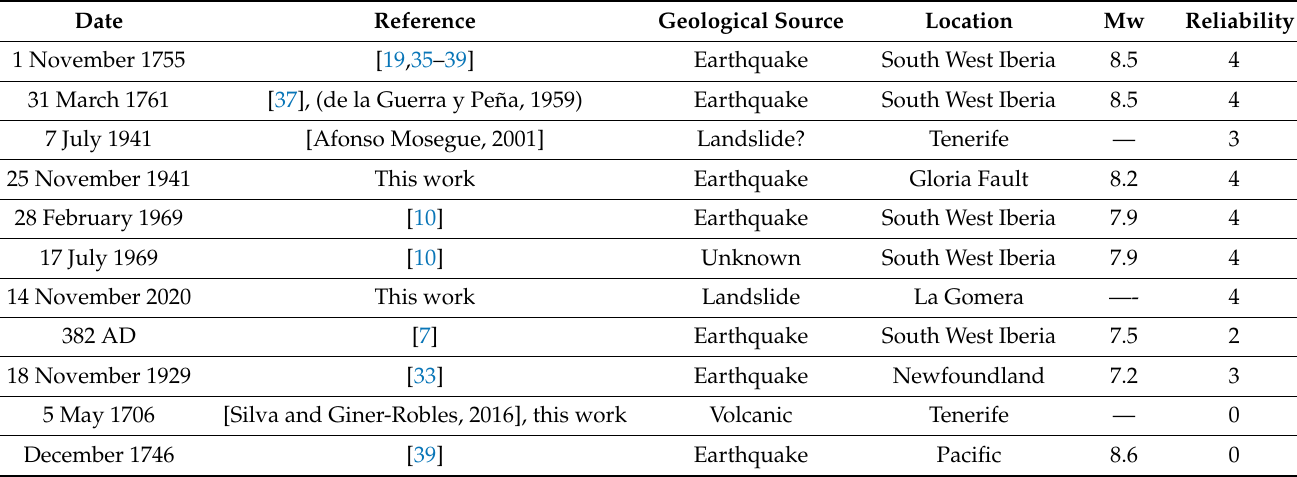
Table 1. Synthesis of the tsunami events collected in this article. Reliability scale of the Italian Tsunami Catalogue (Tinti et al.): 0: Very Improbable Tsunami 1: Improbable Tsunami 2: Questionable Tsunami 3: Probable Tsunami 4: Definite